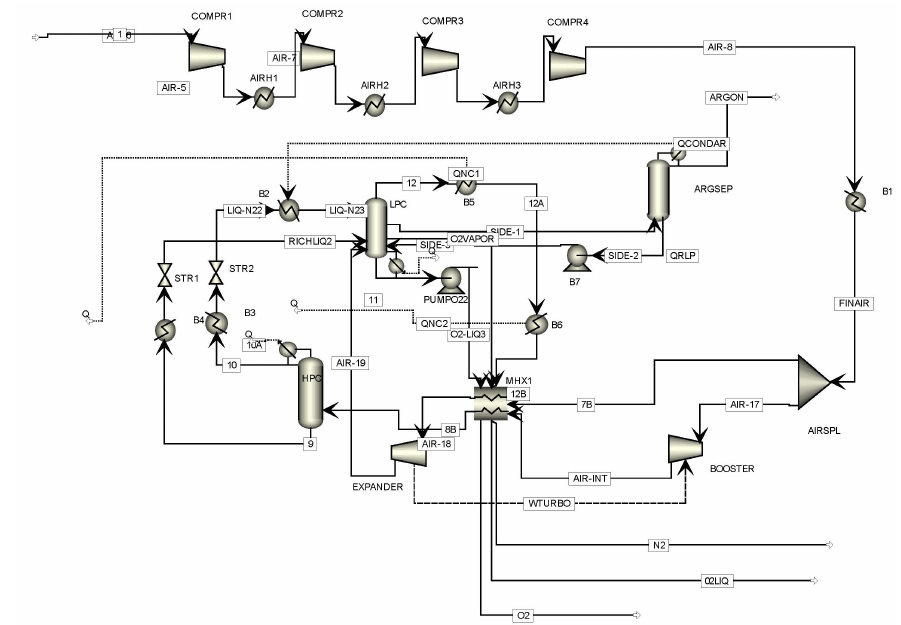
Figure A1. Aspen flowsheet of the ASU model.